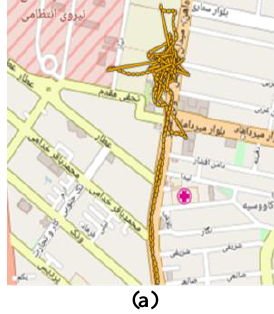
Figure 2a. is a sample trajectory gathered by a user. As it can be seen, there is a concentration of GPS points which is probably a visited place. Figure 2b. is a sample of OSM POIs restricted to a specific